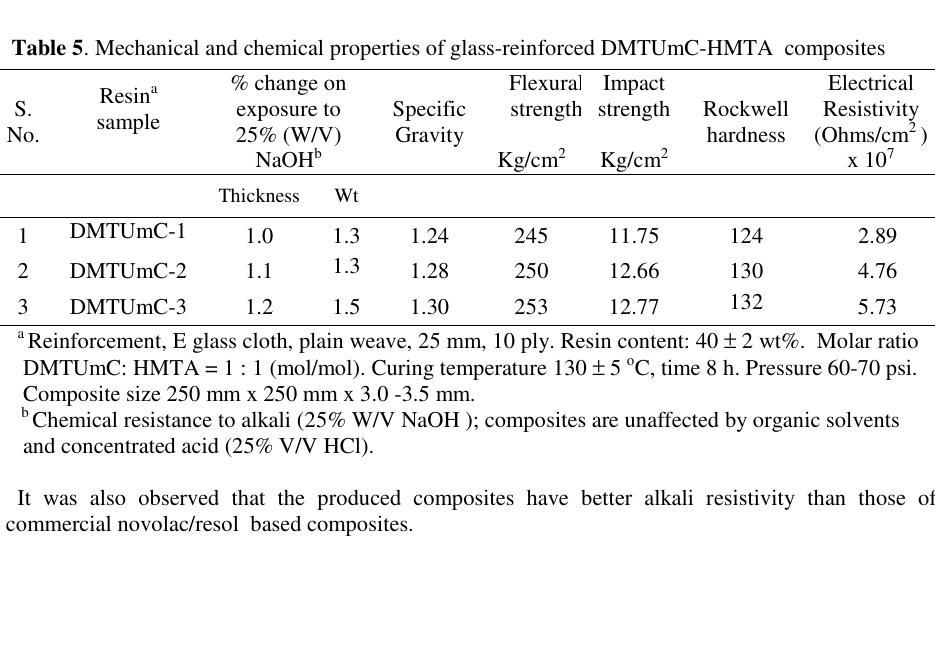
Percent weight loss at given temp. from TGA S.No.